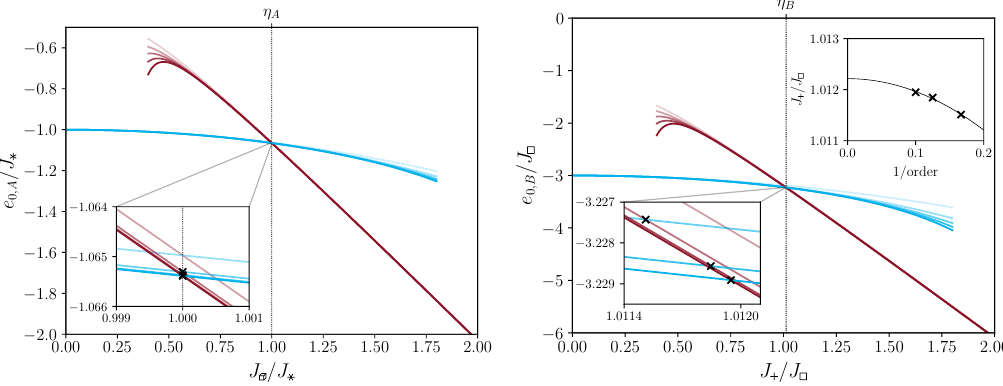
Figure 2: Ground-state energy per vertex of (left panel) and (right panel) H A H B obtained from high-order series expansions. Bare series of even orders from 2 to 10 are shown as solid lines from light to dark colors. Vertical dotted lines indicate the phase transition points η and η . Lower insets : zoom of the ground-state energy A B close to the phase transition points. Crosses indicate the intersection points of the series expansions at order 6, 8, and 10. Upper inset : Crossing points as a function of the inverse order. The thin solid line serves as a guide to the